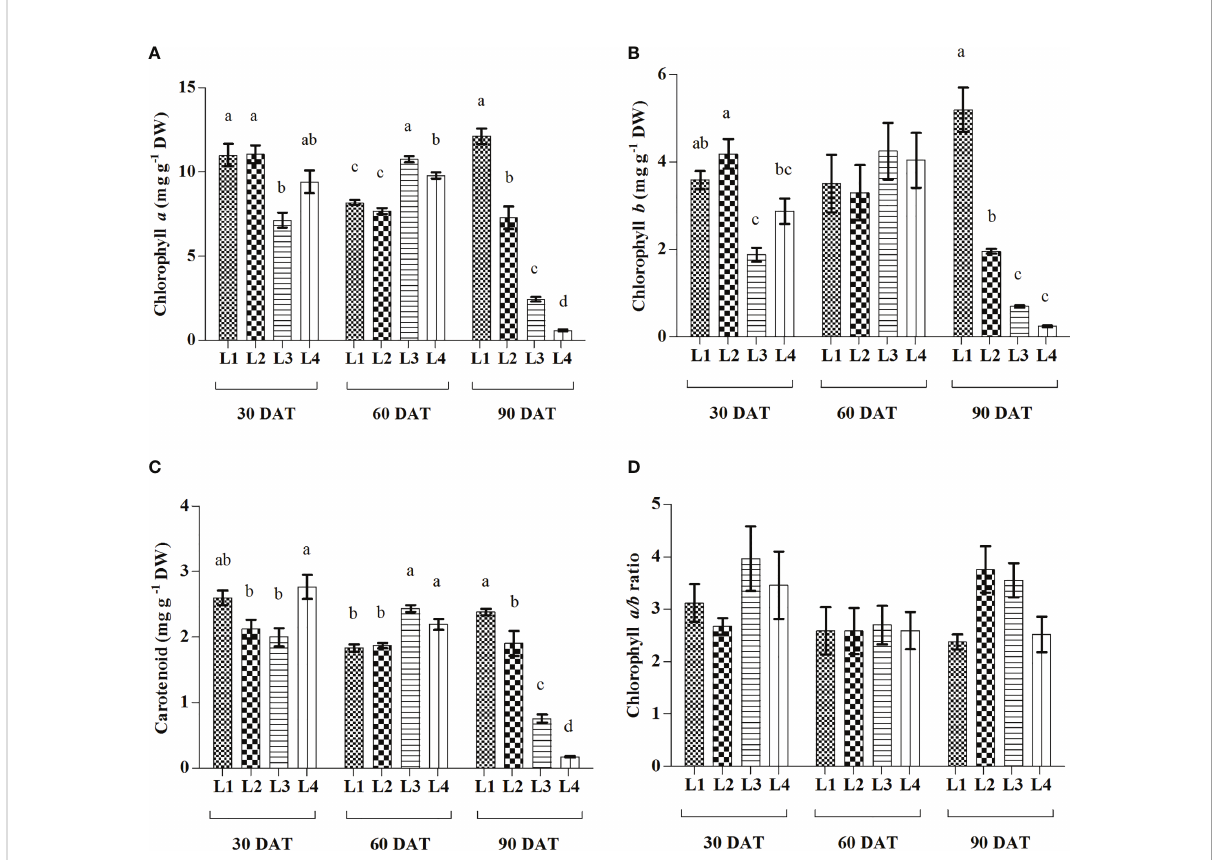
FIGURE 3 Effect of LED spectra on Chlorophyll a (A) , Chlorophyll b (B) , Carotenoid (C) , and Chlorophyll a/b ratio (D) of hemp seedlings at 30, 60, and 90 DAT. Here and subsequent fi gures: L1, MW 240 (Red 35% + Blue 25% + Green 40%); L2, FS 240-UV (Red 40% + UVA and Blue 26% + Green 29% + Far red 5%); L3, MB 240 (Red 85% + Blue 15%); L4, PF 240 (Red 70% + Blue 30%). All treatments used a photosynthetic photon fl ux density of 300 µmol m − 2 s − 1 . Column height indicates the mean, vertical bars indicate the standard error of the mean (n = 4), and different letters indicate signi fi cant differences at p <